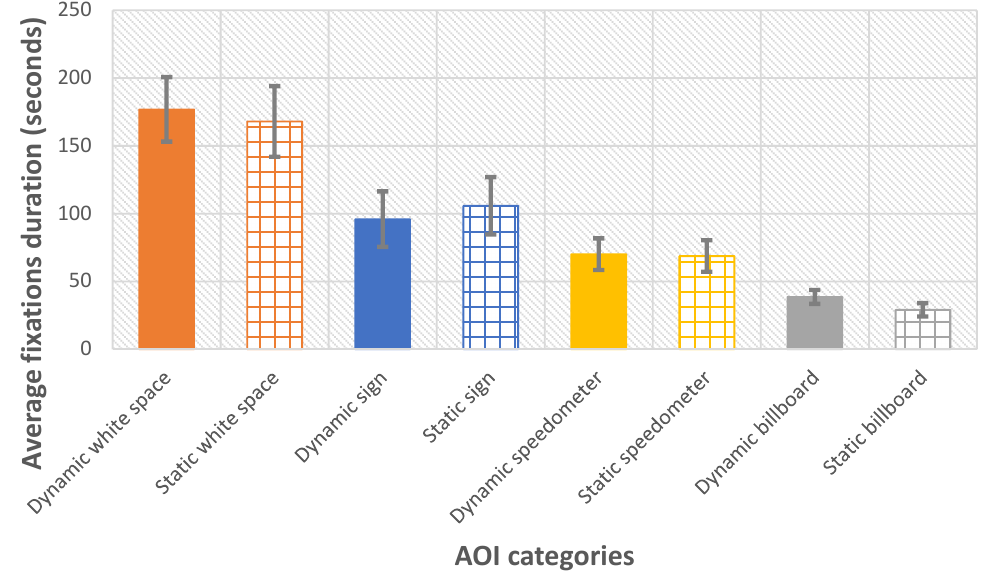
Figure 6. Comparison of average fixations duration in each AOI (white space AOIs, speedometer AOIs, billboard AOIs, speed sign AOIs) between dynamic segment and static segment.